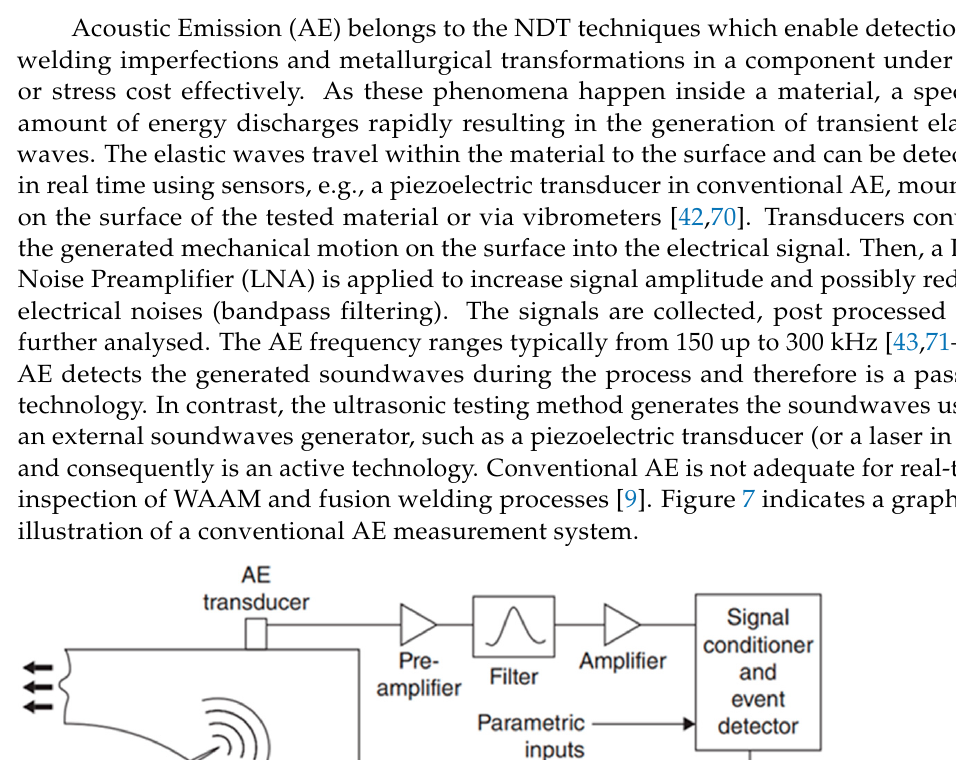
Figure 8. Schematic of the membrane-free optical microphone by Xarion [77]. Various research has been conducted in order to gain deeper knowledge about the AE technology. Ramalho [82] et al. explored the impact of different impurities on the sound waves recorded by a microphone during the WAAM process by means of power spectral density and Short Time Fourier Transform (STFT) analysis techniques. They were able to successfully detect defects. Aboali et al. [83] employed energy, number of counts and amplitude of the AE signals to detect pre-introduced lack of fusion, porosity and slags